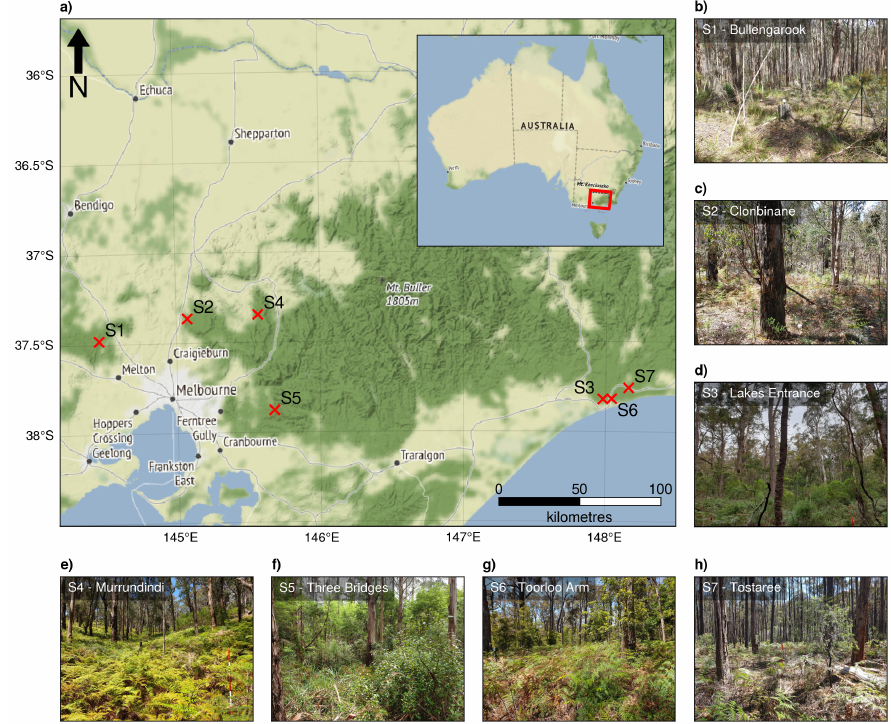
Figure 1. ( a ) The location of the seven study sites in Victoria, Australia. Photos of typical conditions at the ( b ) Bullengarook (S1), ( c ) Clonbinane (S2), ( d ) Lakes Entrance (S3), ( e ) Murrindindi (S4), ( f ) Three Bridges (S5), ( g ) Toorloo Arm (S6), and ( h ) Tostaree (S7)